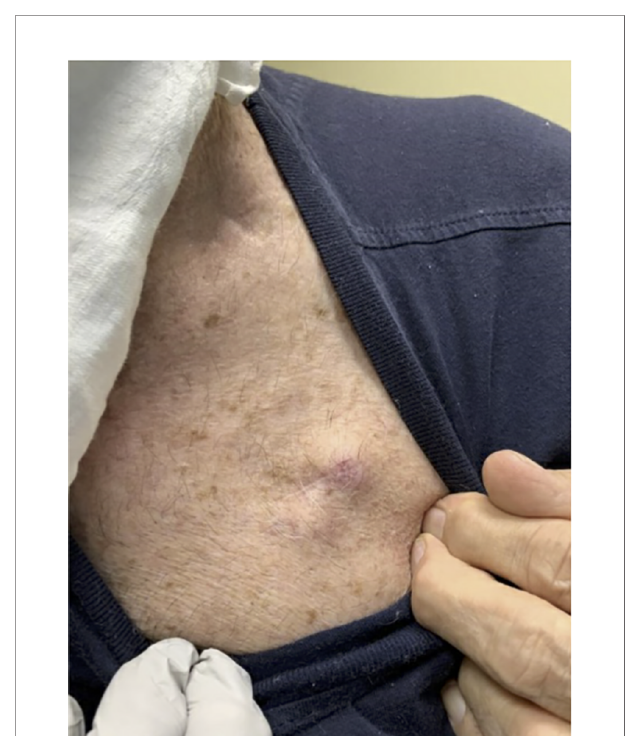
FIGURE 2 | Image of left chest wall